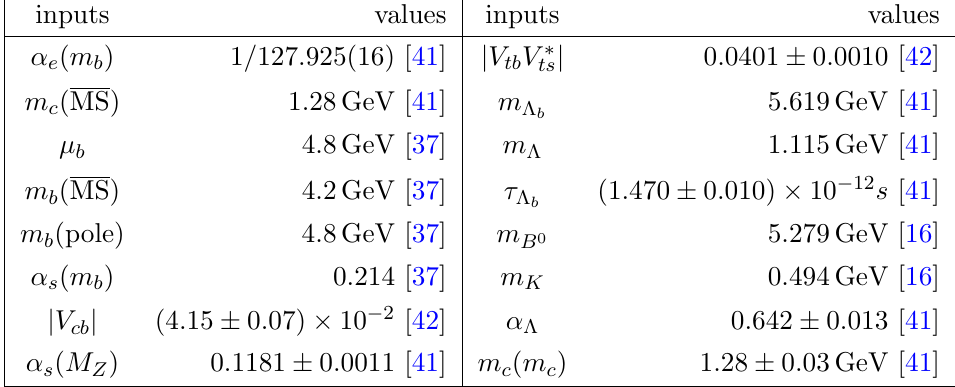
Table 3 . List of inputs and their